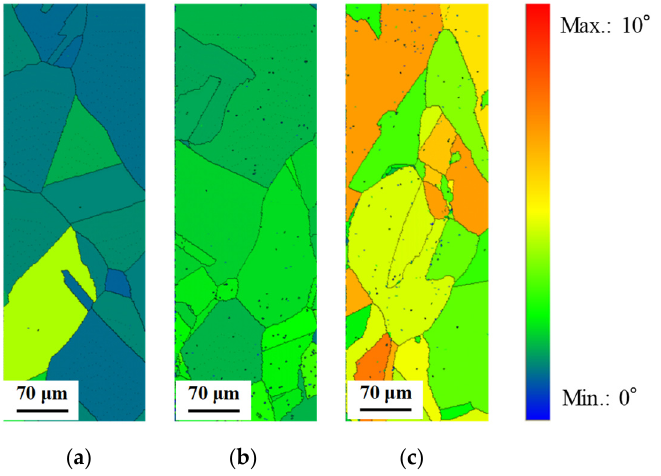
Figure 11. Grain orientation spread (GOS) maps of heat-treated C1020 specimens after low cycle fatigue test. ( a ) Stress amplitude: 50 MPa (fatigue cycle: 7,786,201 cycles); ( b ) stress amplitude: 75 MPa (fatigue cycle: 235,144 cycles); ( c ) stress amplitude: 100 MPa (fatigue cycle: 49,676 cycles).